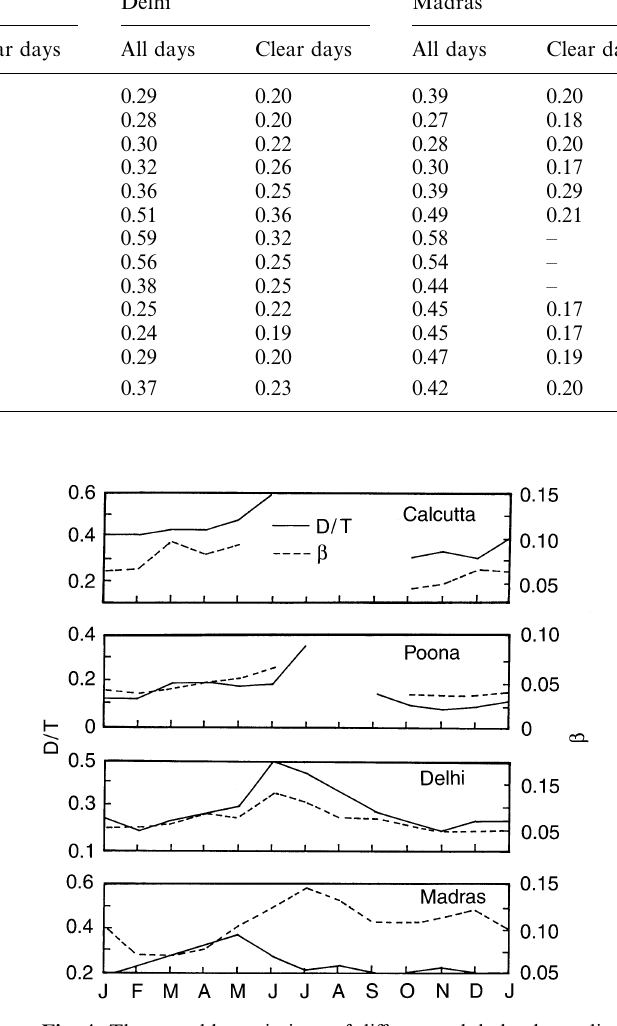
turbidity and severe cloud in summer and monsoon. For example, Poona reveals a very sharp increase in D / „ during the summer and monsoon seasons. Calcutta, with the industrial smoke and turbid and foggy atmosphere presents comparatively higher D / „ values during the win- ter months.